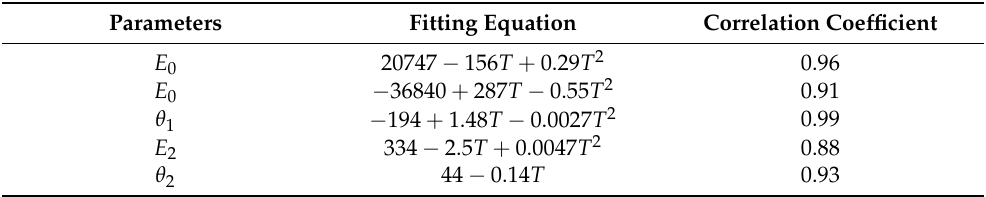
Table 6. The relationship between the parameters of the reinforced Al/PTFE constitutive model and temperature.